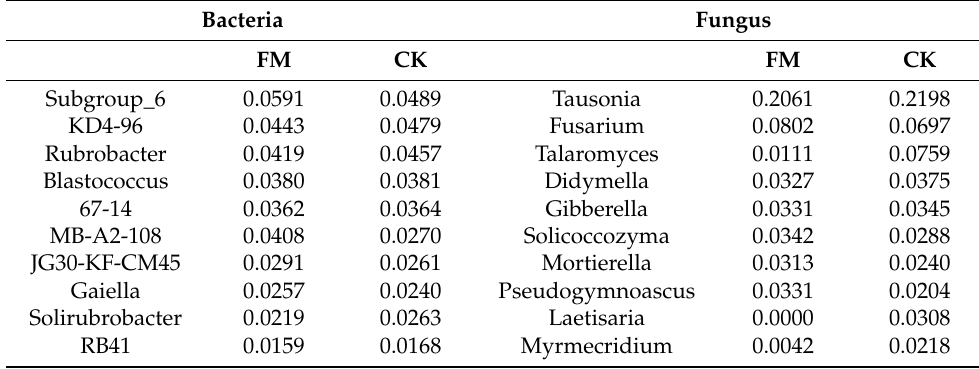
Table A2. Relative abundance table of bacteria and fungi based on heatmap